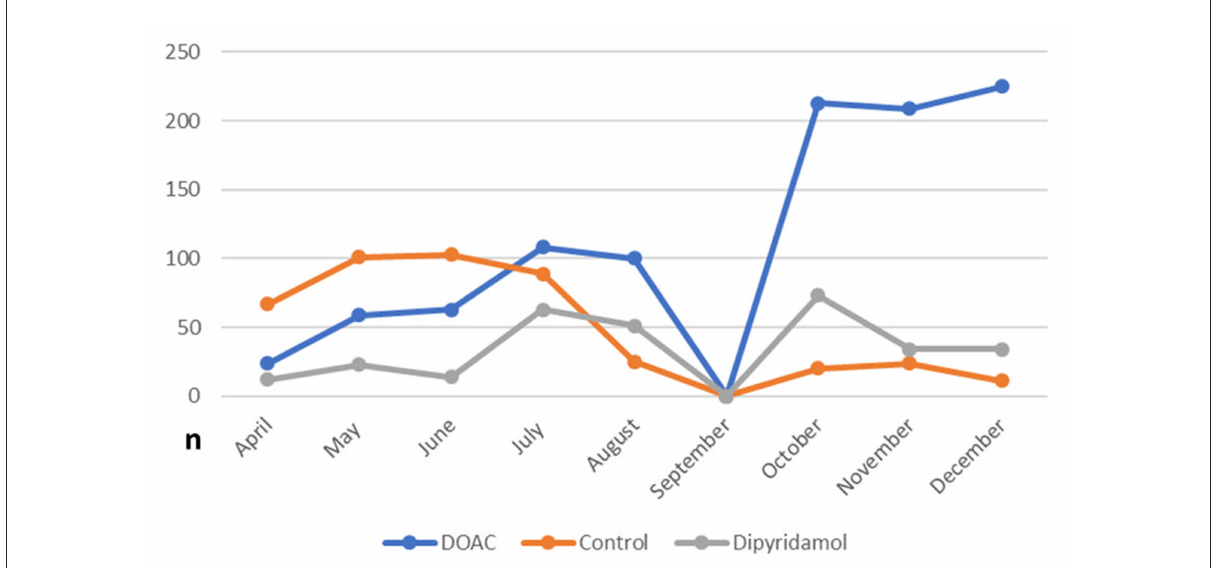
FIGURE2 Frequency of prescribed post-discharge antithrombotic regimes in the study population during the study inclusion period (April to December